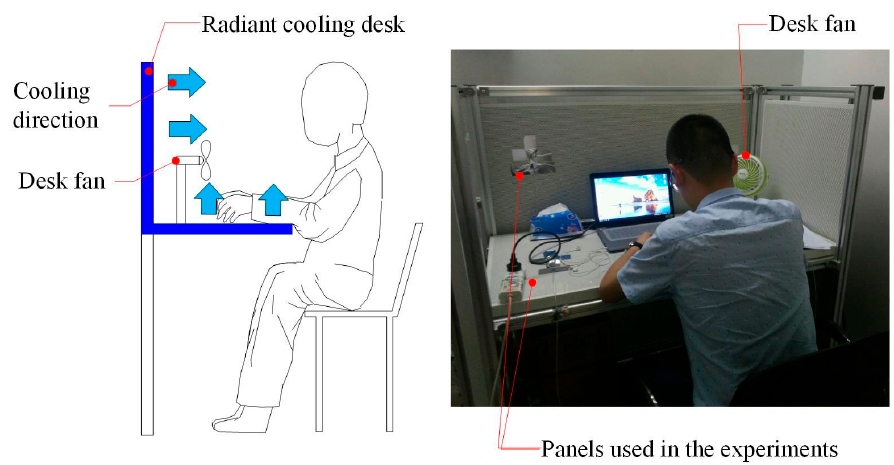
Figure 2. Radiant cooling desk and desk fan used in this study.